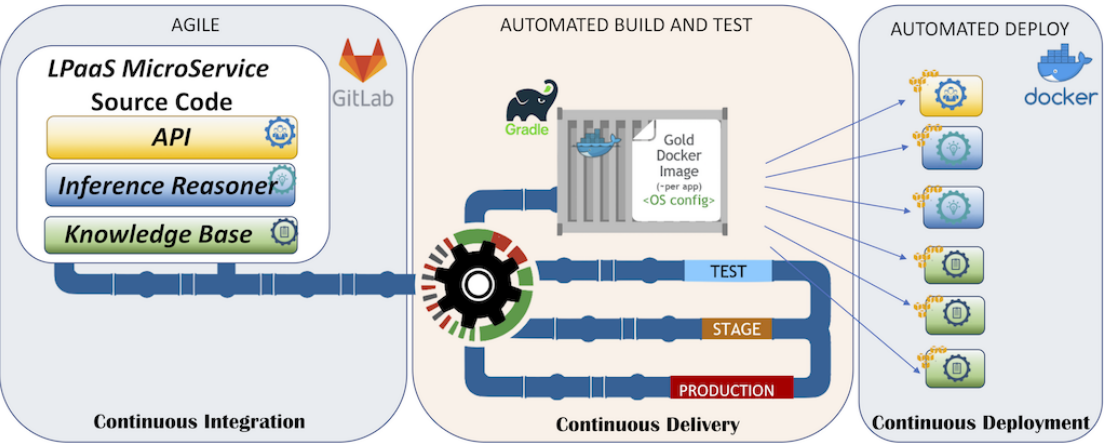
Figure 5. The LPaaS development